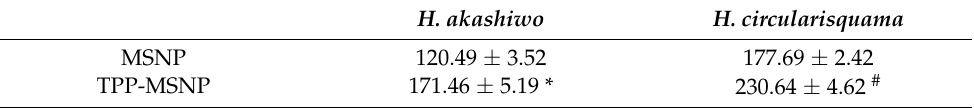
Table 3. Fluorescence absorbance intensity of coumarin-6 labeled MSNP or TPP-MSNP in HABs. Data are presented as mean ± SD ( n = 3). * ,# p < 0.01 compared with MSNP. H.